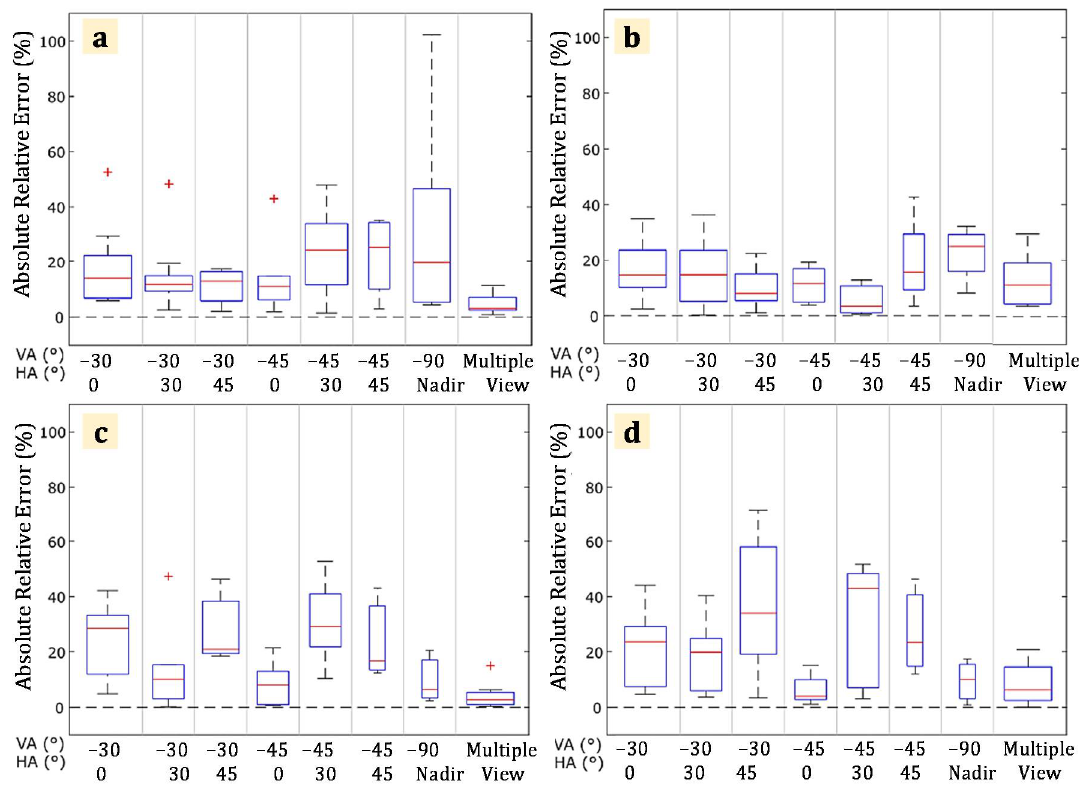
Figure 9. Demonstration of the absolute percentage error of ( a ) leaf length and ( b ) leaf width ( a ) at growth stage BBCH 47, and ( c ) leaf length, 414, and ( d ) leaf width at growth stage BBCH 69. It should be noted that the width of the boxplot represents the number of reconstructed and measurable samples in each growth stage.